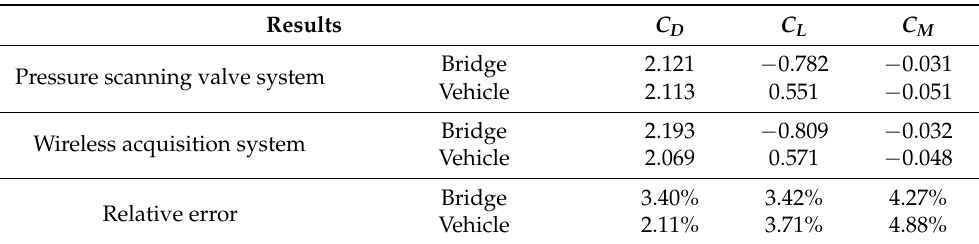
Table 2. Three-component coefficients for Case 1.